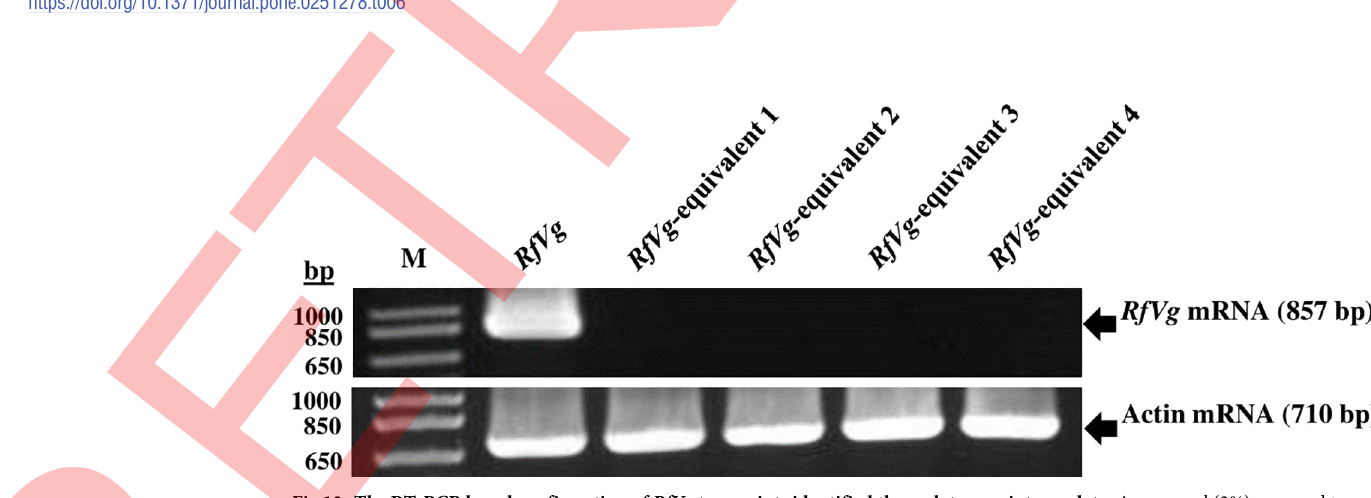
Fig 12. The RT-PCR based confirmation of RfVg transcripts identified through transcriptome data. Agarose gel (2%) was used to analyze the amplified PCR products. M indicates the molecular-weight marker (bp). The size of the RfVg amplified products and actin genes are indicated on the right